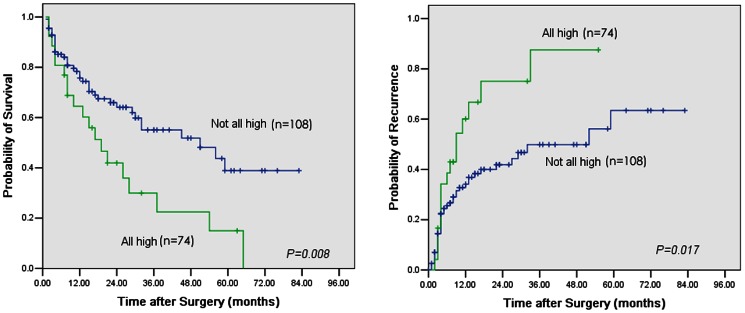
High peritumoral co-expression of VEGF-C, VEGFR-1, and VEGFR-3 was correlated with poor prognosis and early recurrence.
Left: Cumulative overall survival (OS) curves show that patients with high peritumoral co-expression of VEGF-C, VEGFR-1, and VEGFR-3 had poorer OS (Kaplan-Meier, log-rank, p = 0.008). Right: Time to recurrence (TTR) curves showed that patients with high peritumoral co-expression of VEGF-C, VEGFR-1, and VEGFR-3 had shorter TTR (Kaplan-Meier, log-rank, p = 0.017).